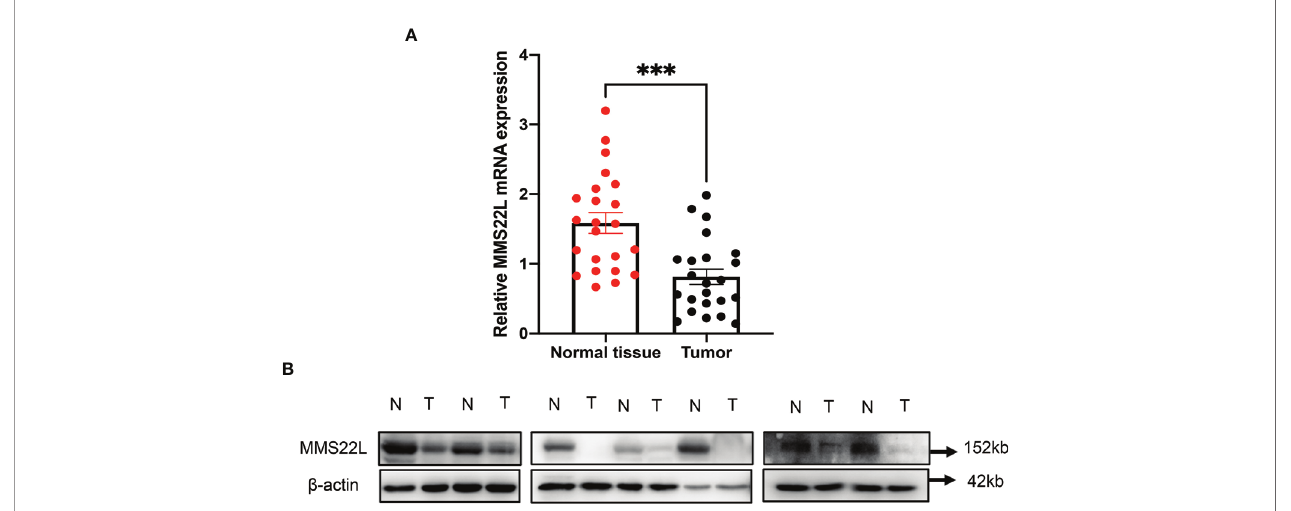
FIGURE 4 | The MMS22L mRNA and protein levels are signi fi cantly lower in cancerous tissues than in normal adjacent tissues. (A) MMS22L mRNA was detected by qRT-PCR, and relative quanti fi cation analysis was normalised to b -actin mRNA (*** p < 0.001). (B) MMS22L protein expression was detected in randomly selected seven ESCC tissues and adjacent normal tissues using Western blotting. T, tumour tissues; N, normal adjacent tissues.